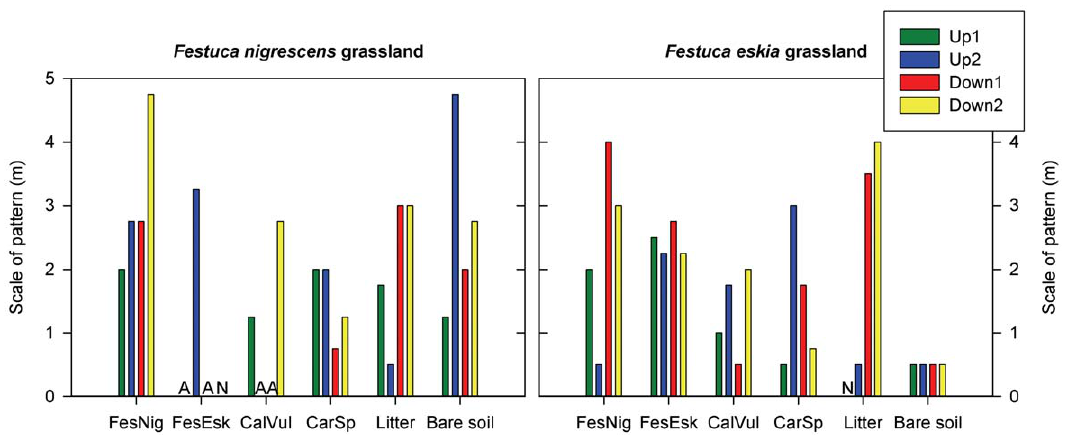
Figure 2. Scale of pattern for each cover type in F. nigrescens or F. eskia grasslands. Cover types: FesNig = Festuca nigrescens ; FesEsk = Festuca eskia ; CalVul = Calluna vulgaris ; CarSp = Carex sp. ( A =cover type absent in the plot; N =scale of pattern is non-significant below